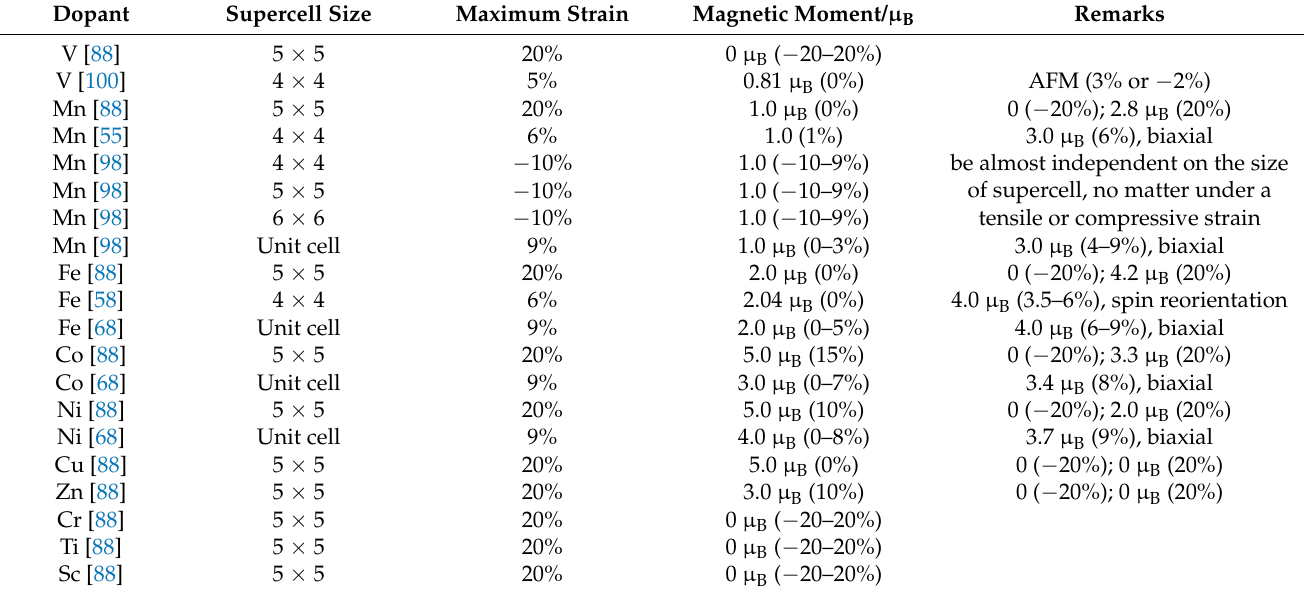
Table 2. Strain-dependent magnetism of TM-doped single-layer MoS 2